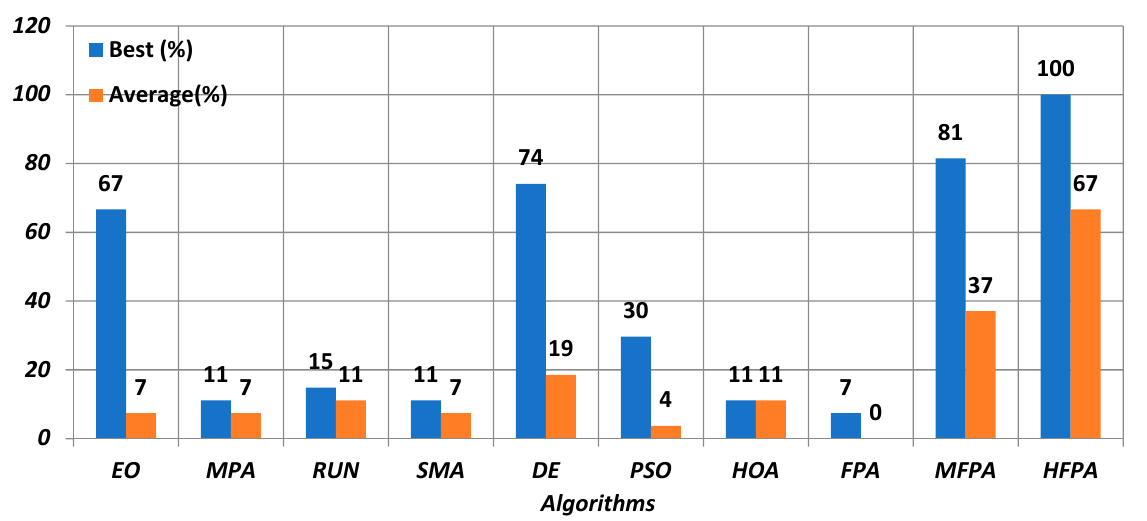
Figure 9. Outperformance and competitiveness percentage of each algorithm in terms of best and average values on NESs.